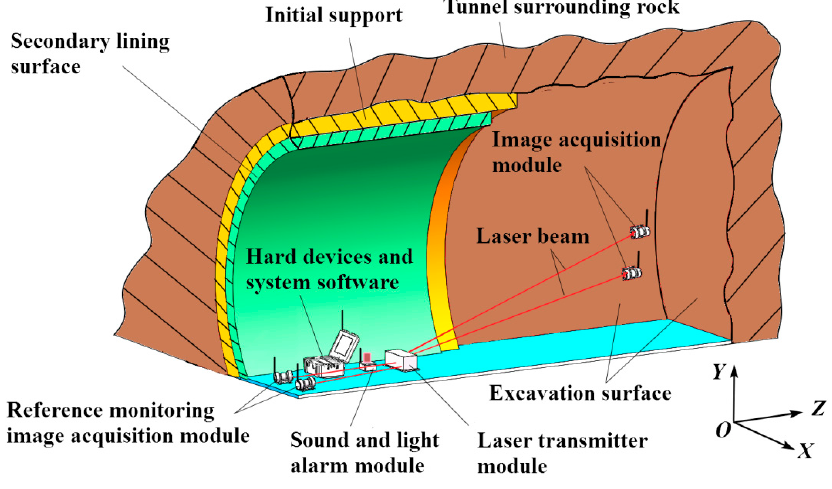
Figure 1. System Figure 1. System principle.